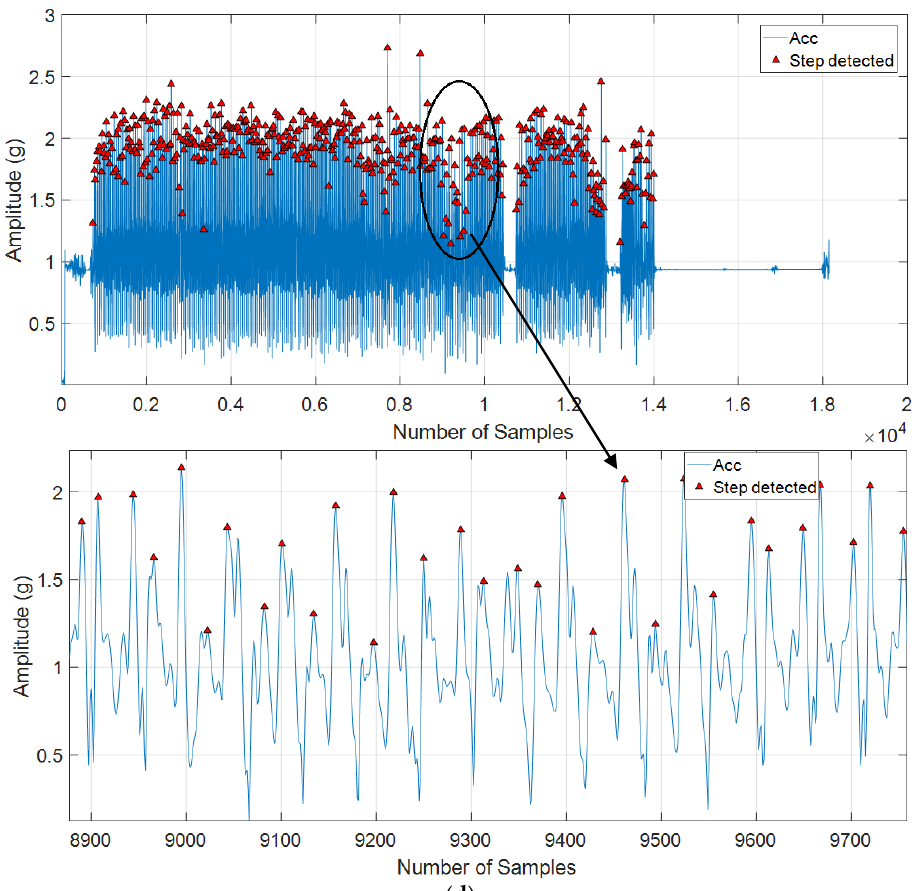
Figure 10. The estimated step numbers in various kinds of walking speeds: ( a ) Results after executing 227 steps of normal walking with the distance of 162 m; ( b ) Results after executing 500 steps of slow and intermittent walking; ( c ) Results after executing 187 steps of fast walking with the distance of 162 m; and ( d ) Results after executing 500 steps in free walking (floor walking, up stairs, down stairs).